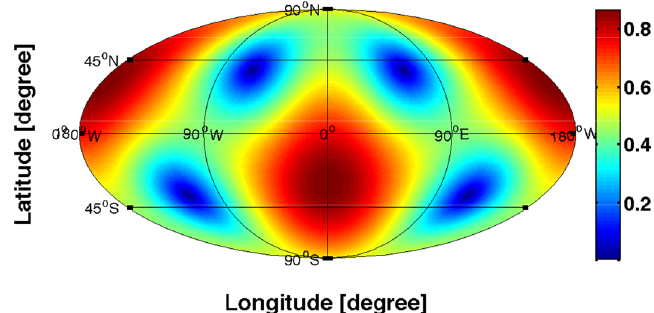
Fig.41 AsingleframeofananimationshowingthetimeevolutionoftheLISAantennapattern,represented as a colorbar plot on a Mollweide projection of the sky in ecliptic coordinates. Maxima (minima) of the antenna pattern are shown by the red ( blue ) regions . The full animation corresponds to a period of 1 year. To view the animation, please go to the online version of this review article at http://dx.doi.org/10.1007/